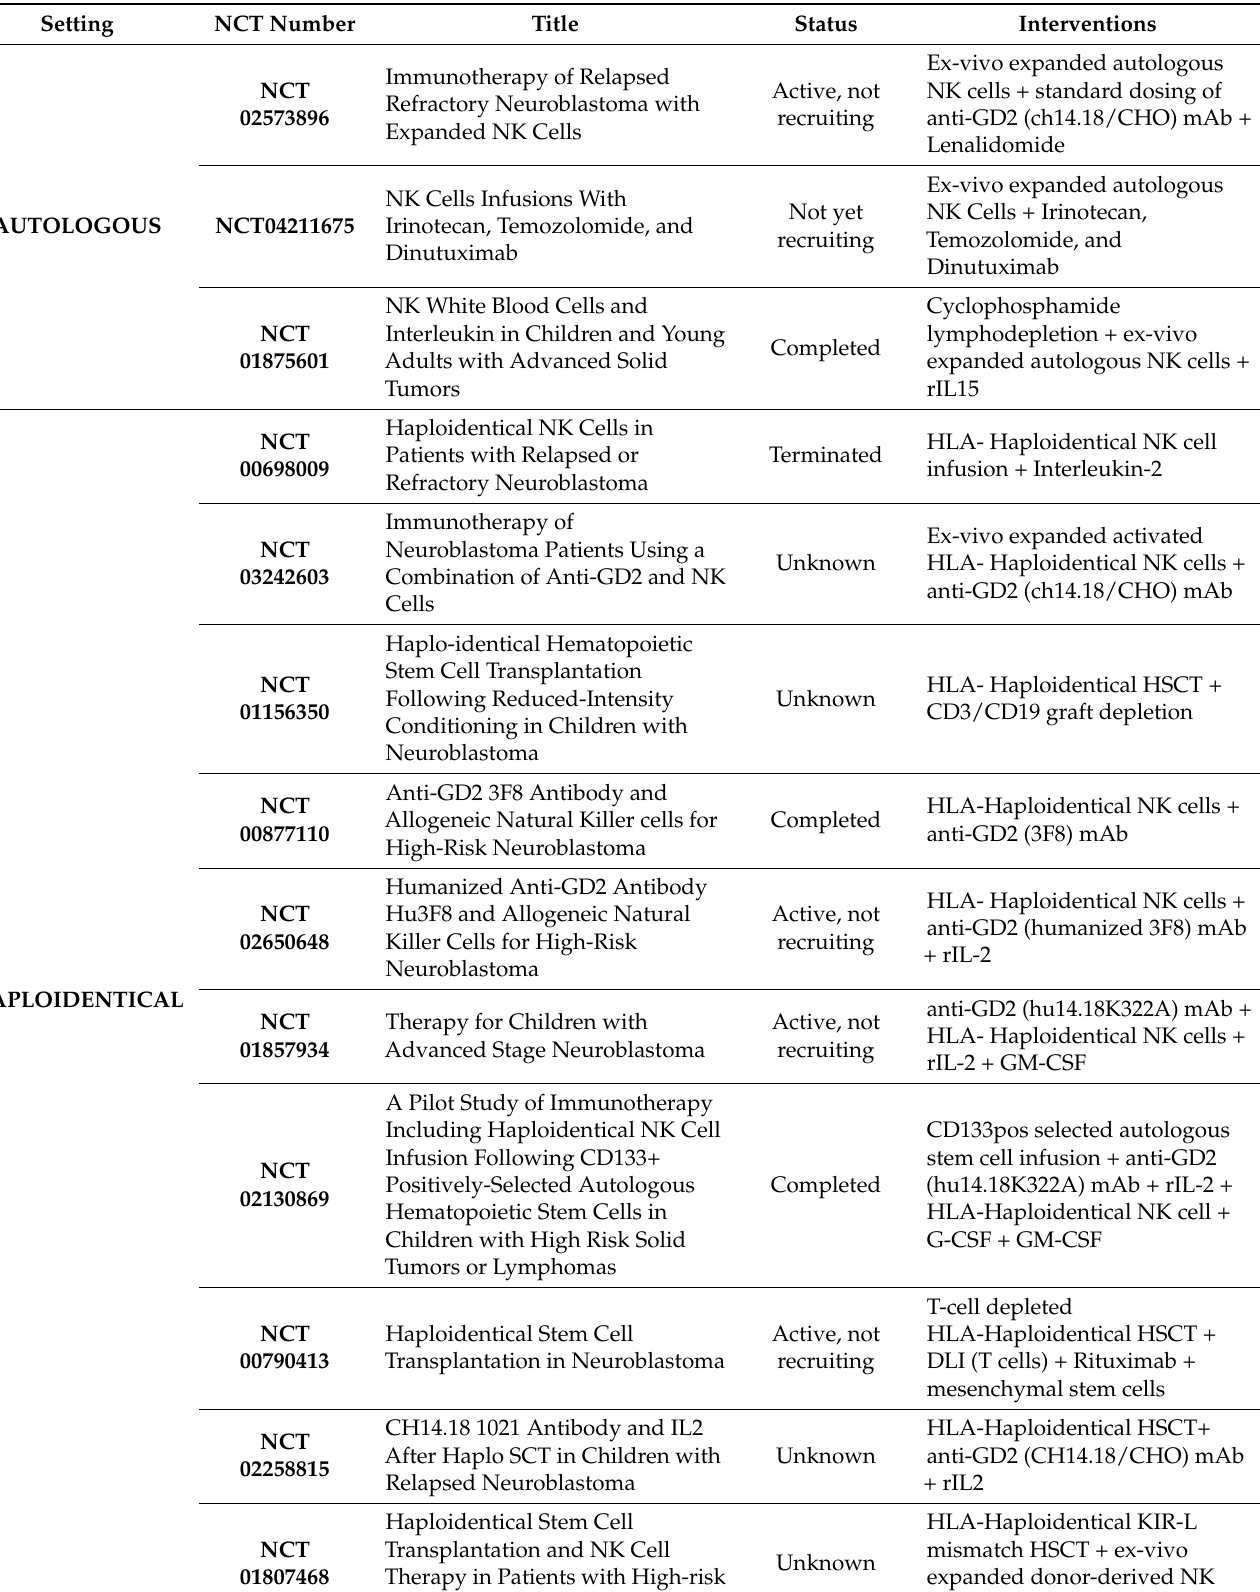
Table 1. Clinical trials exploring different HSCT and NK cell infusion settings in NB patients. Source: www.clinicaltrials.gov (accessed on 3 August